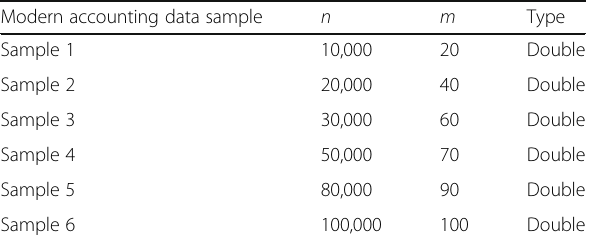
Table 1 Experimental data Modern accounting data sample